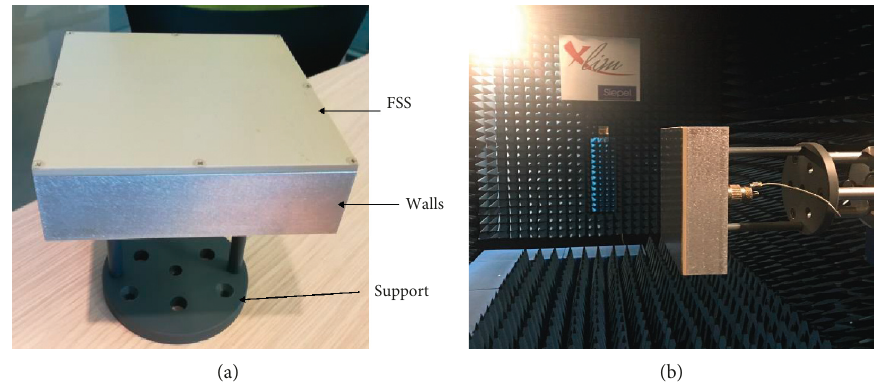
Figure 9: (a) Pixel antenna with supports. (b) Measurements of the radiation pattern in an anechoic chamber.